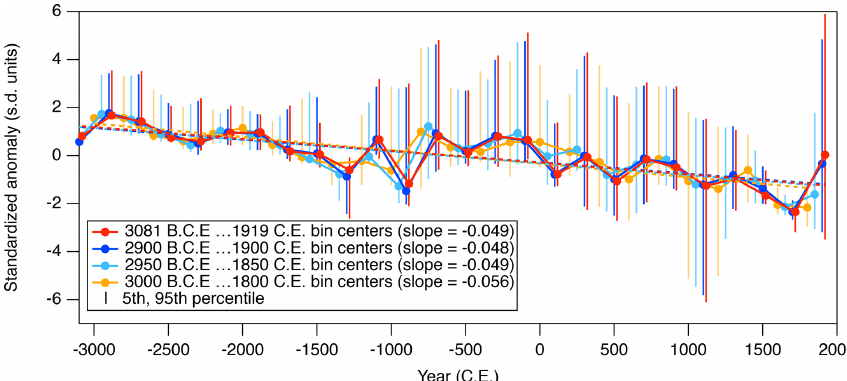
Figure 9. SMB composites made by connecting medians in consecutive 200-year bins. Different colors indicate different ranges of bins (offset by ∼ 50 years). The vertical bar indicates the 5th–95th percentile. The dotted line indicates a statistically significant long-term trend.